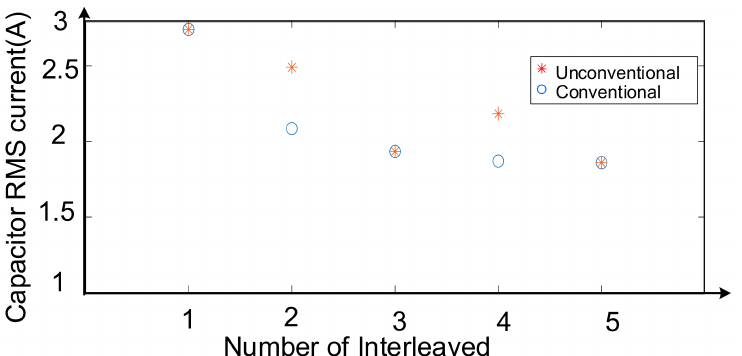
Figure 9. Input ripple current of the DC capacitor on the basis of the number of the interleaved converters with f sw = 37.5 kHz, P 0 = 1 kW, and L boost = 1 mH based on PLECS software simulations. The conventional phase shift is considered 360 ◦ /N and unconventional is selected based on the (17) and